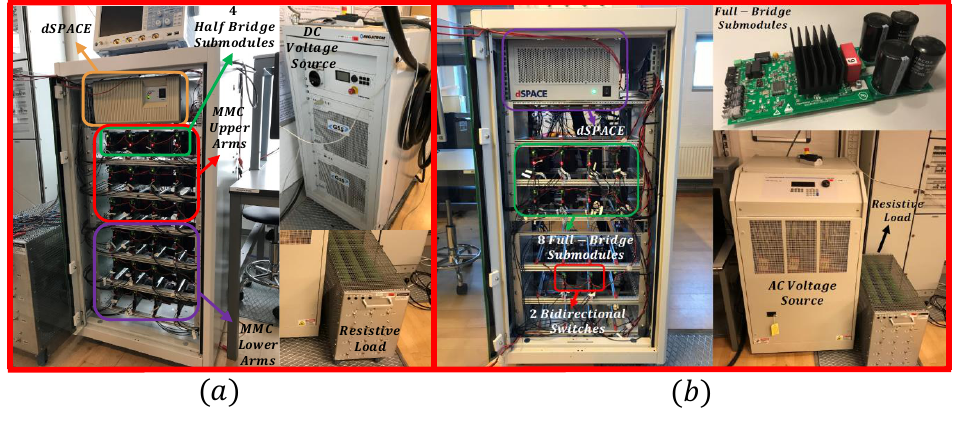
Figure 7. ( a ) MMC test setup and ( b ) MMSC test